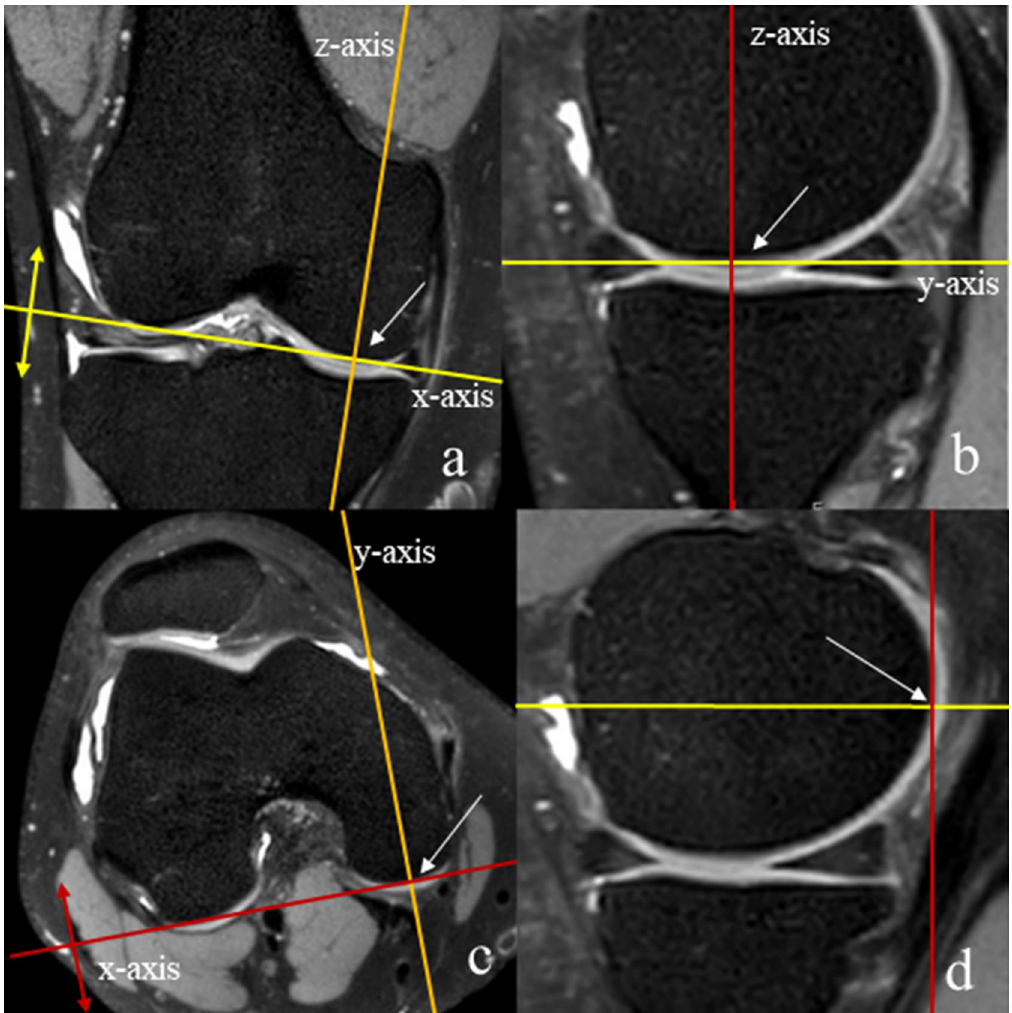
Figure 3. Alignment of the axial plane ( a , b ; yellow lines) and the coronal plane ( c , d ; red lines). The yellow line representing the axial plane was tangentially aligned to the femoral condyles inferiorly and posteriorly. This alignment was performed in the axial, coronal and sagittal plane. The white arrow marks the center of rotation of the 3D coordinate